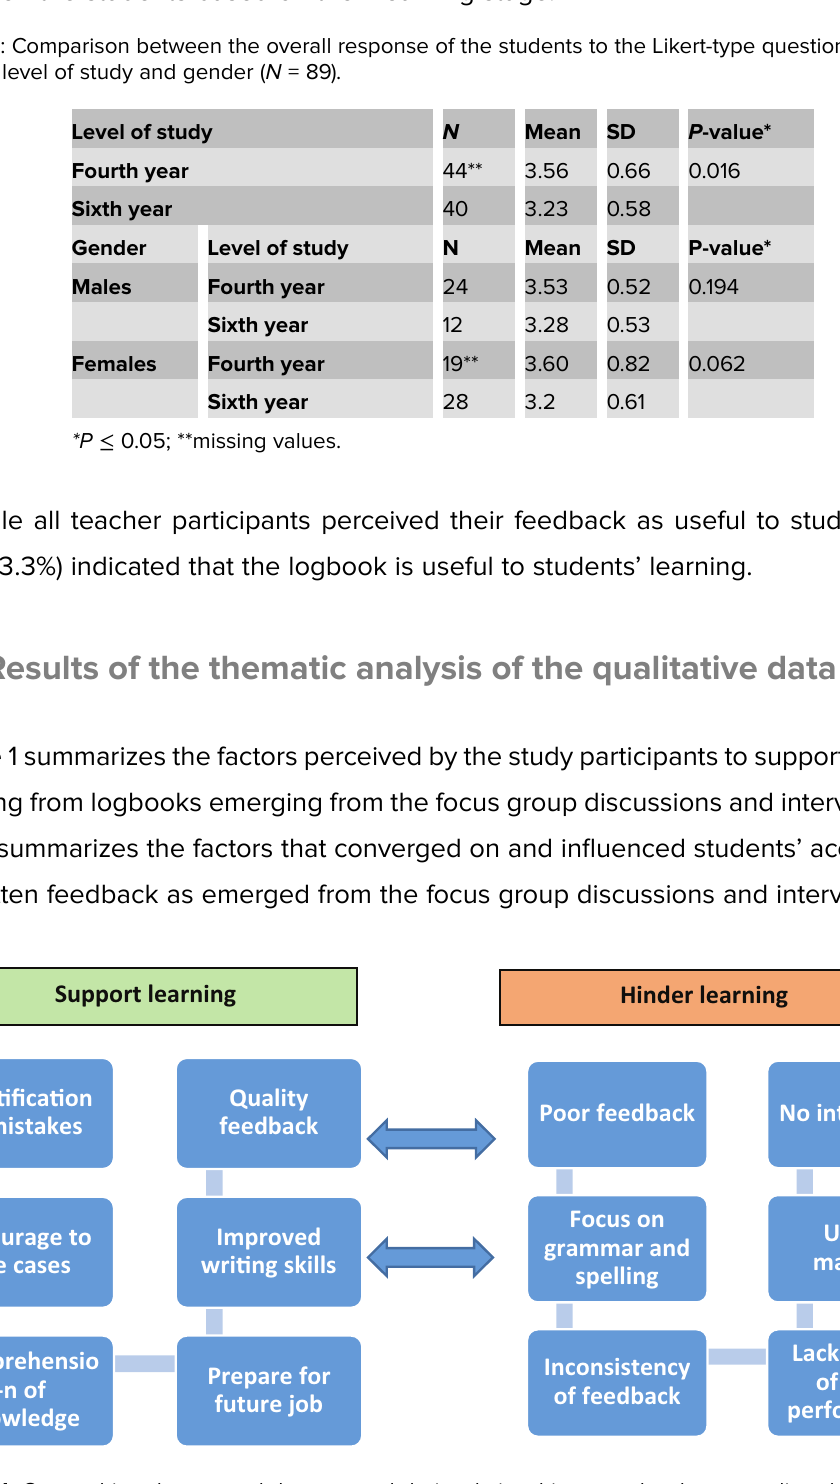
Figure 1 : Overarching themes, subthemes, and their relationship to each other regarding the perceived usefulness of logbooks to student learning ( arrows indicate a dual role for the factors